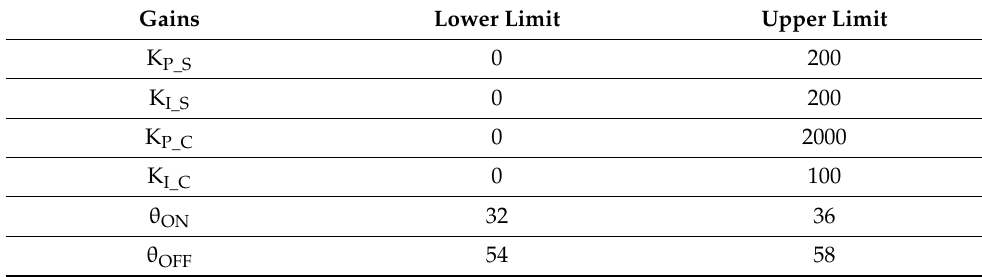
Table 8. Range of gains for PI controller and commutation angle controller.